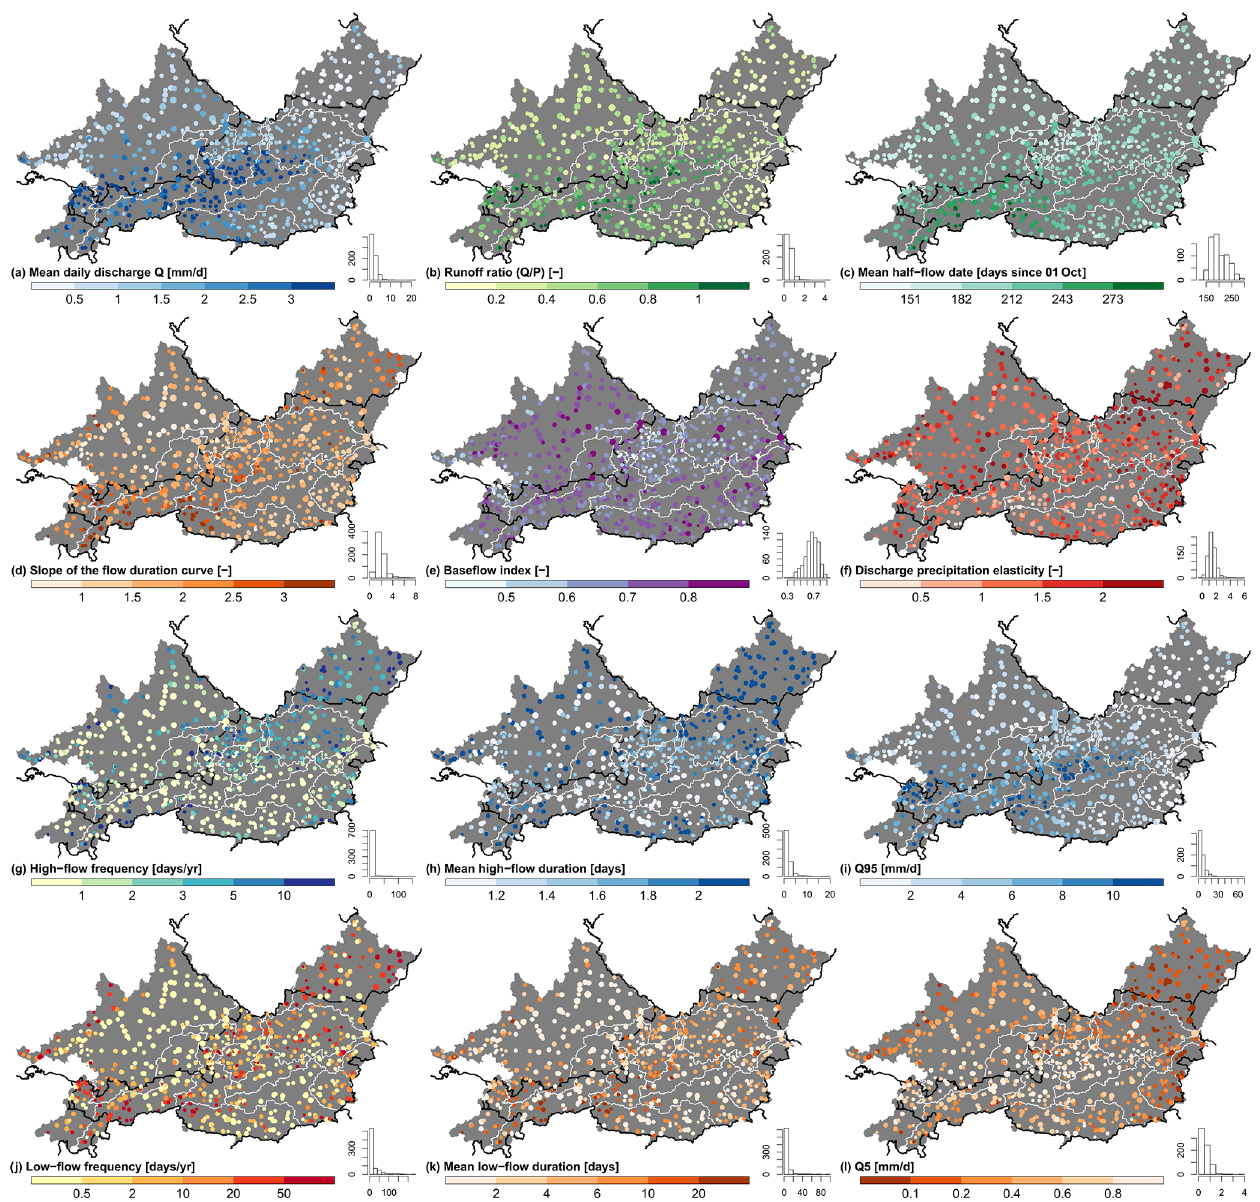
Figure 7. Spatial distribution of hydrological signatures. Only gauges are plotted which cover the period 1 October 1989 to 30 September 2009. The histograms indicate the number of gauges (out of 717) in each category. The size of the circles is proportional to the catchment area. © EuroGeographics for the administrative